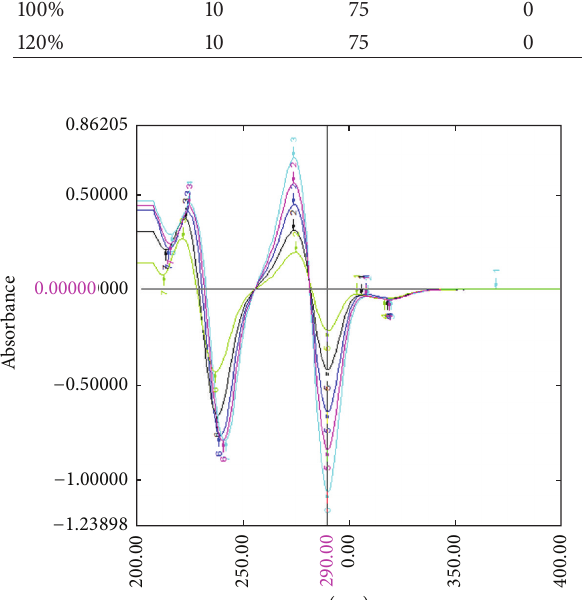
Figure 11: Calibration curve of Prasugrel (6–22 𝜇 g/mL) by ratio first order derivative method.